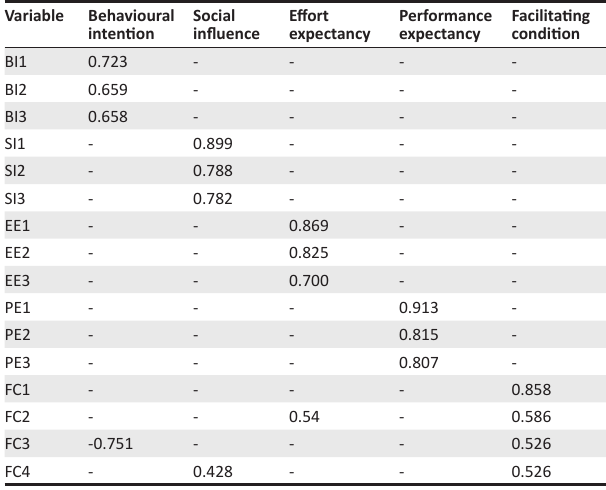
TABLE 3: Varimax rotated component